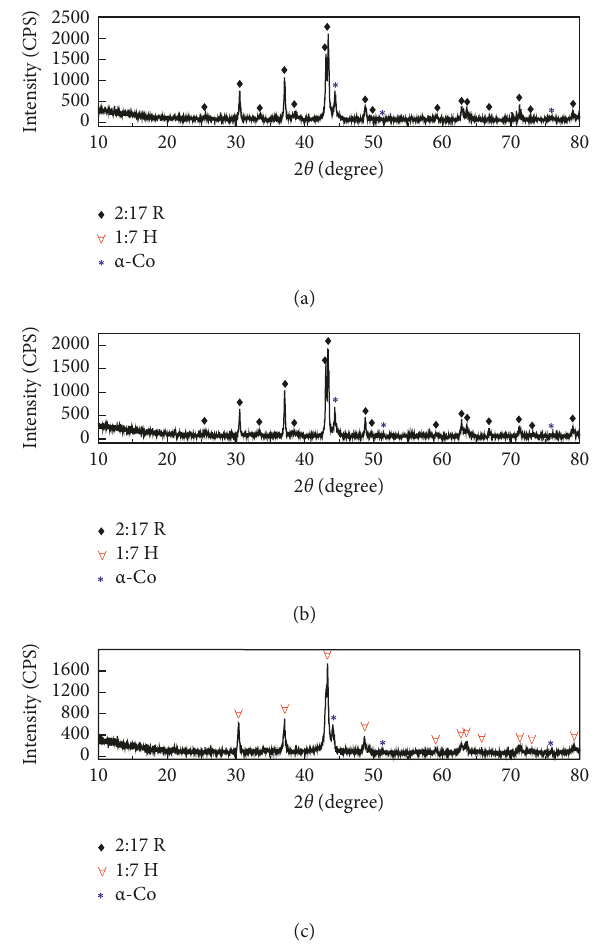
Figure 1: XRDpatternsofSmCo 10 alloys at differentstates. (a)As-cast alloy. (b) Annealed alloy. (c) As-spun